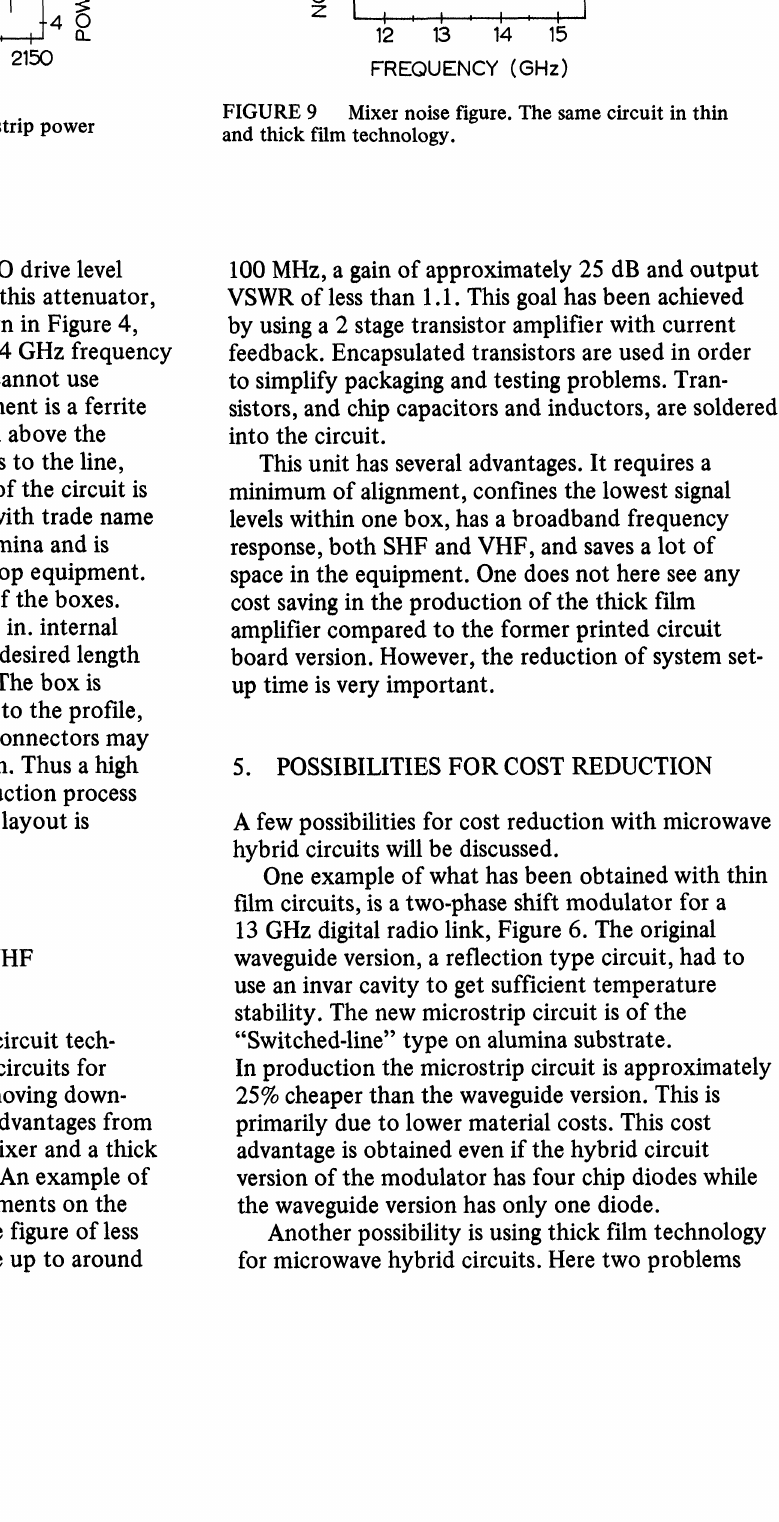
Mixer noise figure. The same circuit in thin and thick film